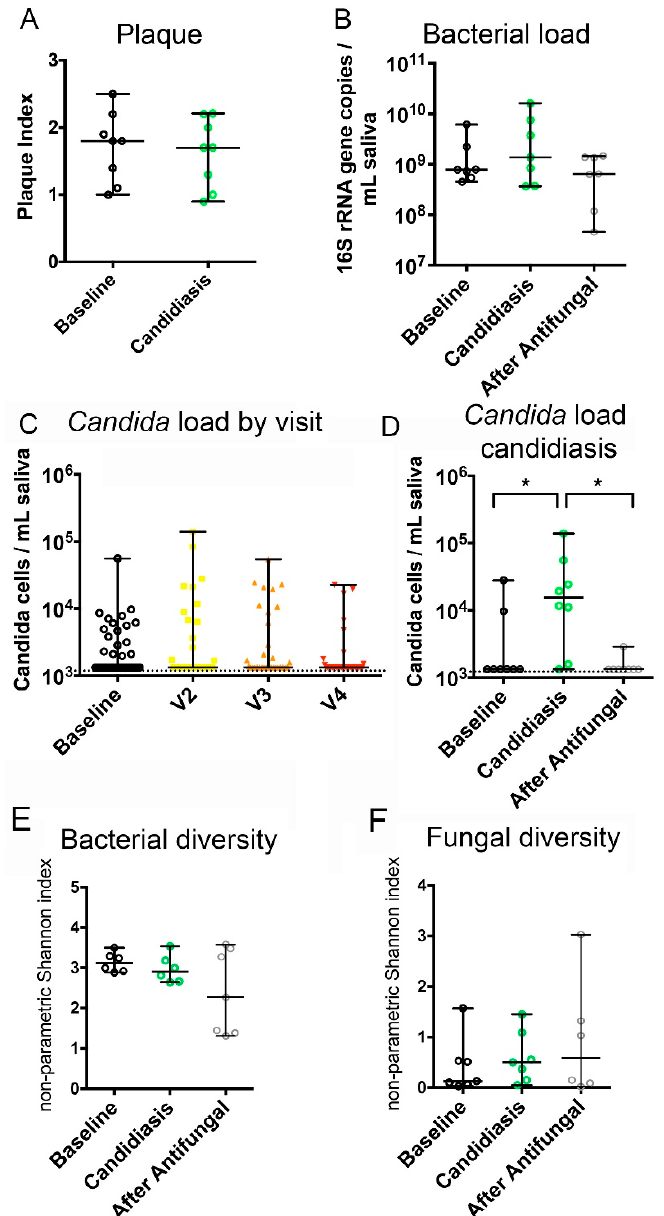
Figure 3. Changes in the bacterial and fungal burdens and community diversity during the development of oral candidiasis. ( A ) Changes in Plaque Index between baseline and the first visit with candidiasis. ( B ) Changes in salivary bacterial load as subjects developed oral candidiasis and after antifungal treatment. ( C ) Changes in salivary Candida load in all subjects, during the chemotherapy cycle. ( D – F ) Changes in Candida load, bacteriome diversity, and mycobiome diversity, as subjects developed oral candidiasis and after antifungal treatment. *indicates a p value < 0.05, when comparing subject-matched data via Wilcoxon Rank tests.